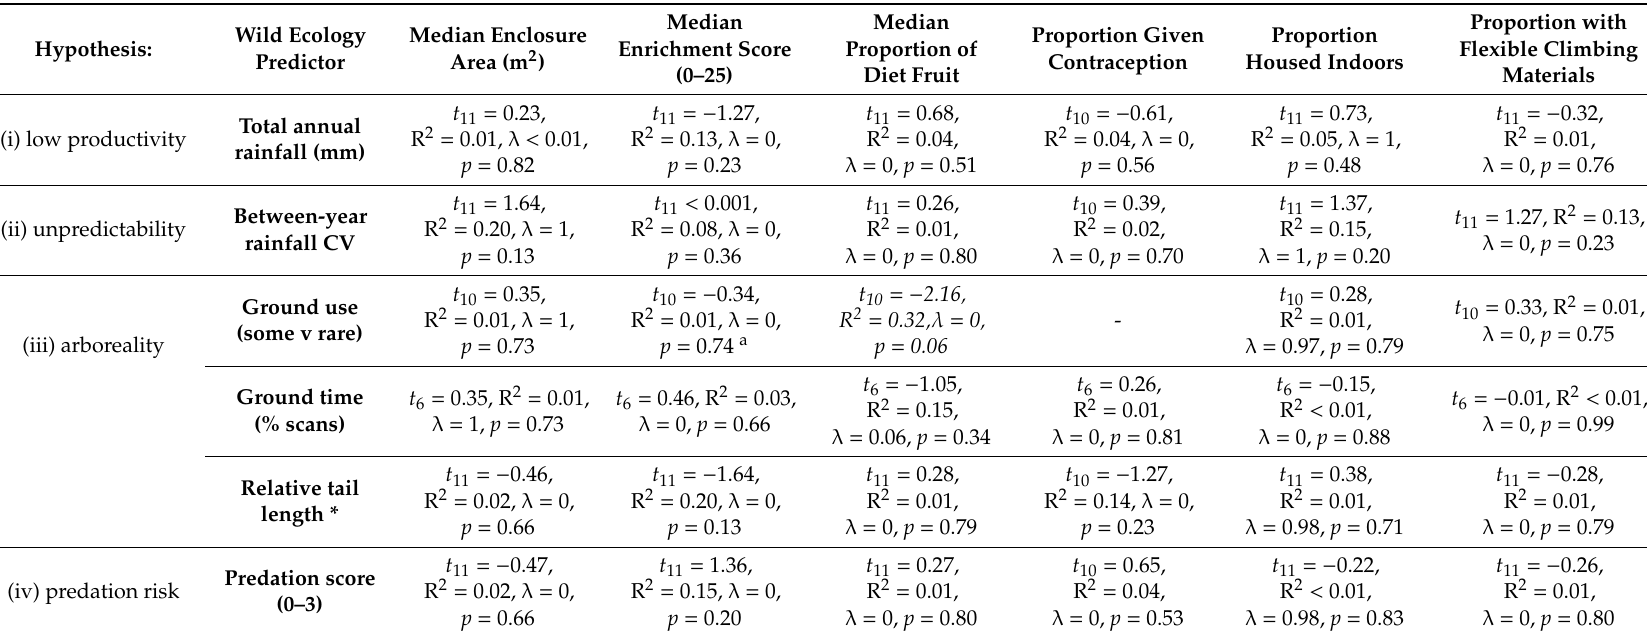
Table A3. Results of PGLS models investigating potential relationships between species-typical husbandry and wild ecology predictor variables. In all models the husbandry variables are outcome variables. Dashes indicate an analysis could not be performed due to too few species per level for ground use (see Section 2.5.1). CV = coe ffi cient of variation. Results in bold were considered significant at p < 0.05, and trends ( p < 0.10) are italicised. All p values are